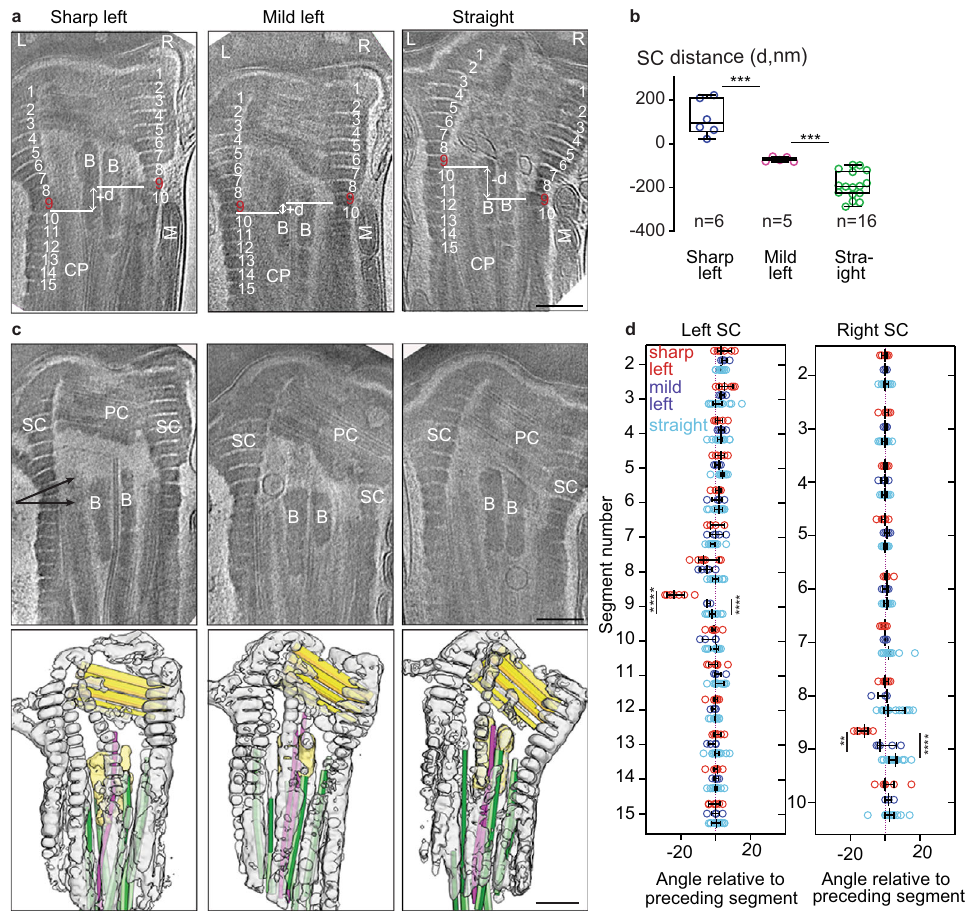
Fig. 4 Segmented columns slide during sperm tail beating. a , b Slices through Volta phase plate (VPP) cryo-tomograms of three types of sperm tail bending oriented according to COSA. Segmented columns (SCs) are labeled and numbered starting from the topmost segment as 1 and onward ( a ). Plot b shows the relative distance ( d ) between the left SCs segment and its corresponding right SCs segment. Negative values indicate that segment 9 on the right is lower than segment 9 on the left ( “ − d ” ), while positive values indicate that segment 9 on the right is higher than segment 9 on the left ( “ + d ” ). Data are presented as box and whisker plots, where upper and lower bounds show interquartile range, line within the box shows median, and whiskers show minimum and maximum data points. Experiment was repeated twice independently with similar results. c Computational slices through cryo-tomograms of sperm with varying extents of tail bending (upper panels) and corresponding three-dimensional segmentations (lower panels). Labels: SC segmented columns, B bars. Color scheme: gray: segmented columns, dark yellow: proximal centriole triplets, green: distal centriole doublets, pink: central singlets, pale yellow: bars. Two angular arrows in the upper panel mark the area where the SCs bend when the head kinks to the left. d Relative angles between each segment. Every data point represents a cell, and lines represent mean ± sd. The experiment was repeated twice independently with similar results. All statistical analyses used are an unpaired, two-tailed t -test. ** P < 0.01, **** P < 0.0001. Source data are provided as Source Data File. Scale bars: 250 (Fig. 3e, f, Supplementary Fig. 11e, Supplementary Fig. 12, Supplementary Movie 8). A similar kink was observed in the past